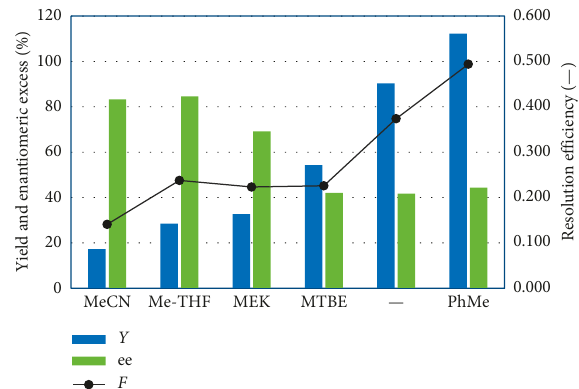
Figure 3: Effect of the third solvent on resolution results.